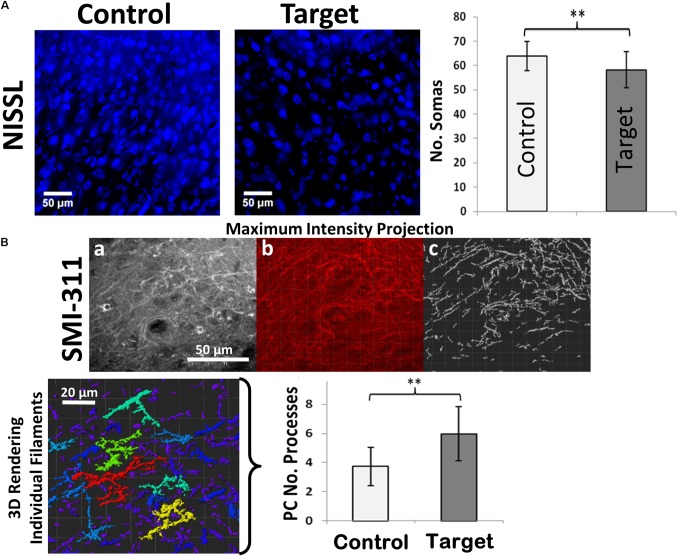
Neuronal loss and dendritic branching. (A) Immunofluorescence staining of Nissl-stained neuronal somas (blue) showing neuronal loss in target compared to healthy control areas. (B) SMI-311 staining shows neurofilament overexpression and neurons with tortuous processes in target areas. (a) A maximum intensity projection of a single SMI-311 stack demonstrates the diverse interwoven processes of local neurons. (b) A blended rendering is generated in the IMARIS suite in order to highlight the internal shadowing generated by the image depth. (c) Finally, the IMARIS suite is utilized to model processes with high levels of contrast, allowing for rapid visualization of filament density within the slice. The technique also simplifies the process of visualizing individual structures, which IMARIS suite can then color-code based on the quantity of sub-branches in the 3D rendering of individual filaments incorporating the entire Z-stack (bottom-left). Scale bars: 50 μm. Graphs showing the number of neuronal somas and number of neuronal processes in target and control (contralateral hemisphere) areas. Values represented as mean ± SD (N = 8). Significant differences referred as: ∗P < 0.05 (Paired t-test) and ∗∗P < 0.01 (Paired t-test). These representative images were taken covering layers II-IV.